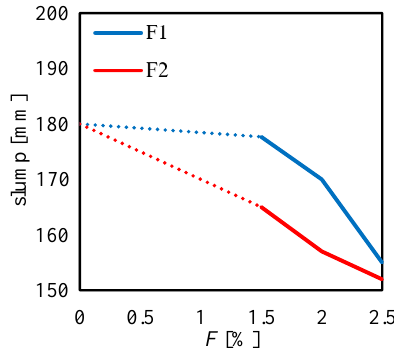
Figure 5. Slump measured for the F1 and the F2 fibers by varying the fiber content F